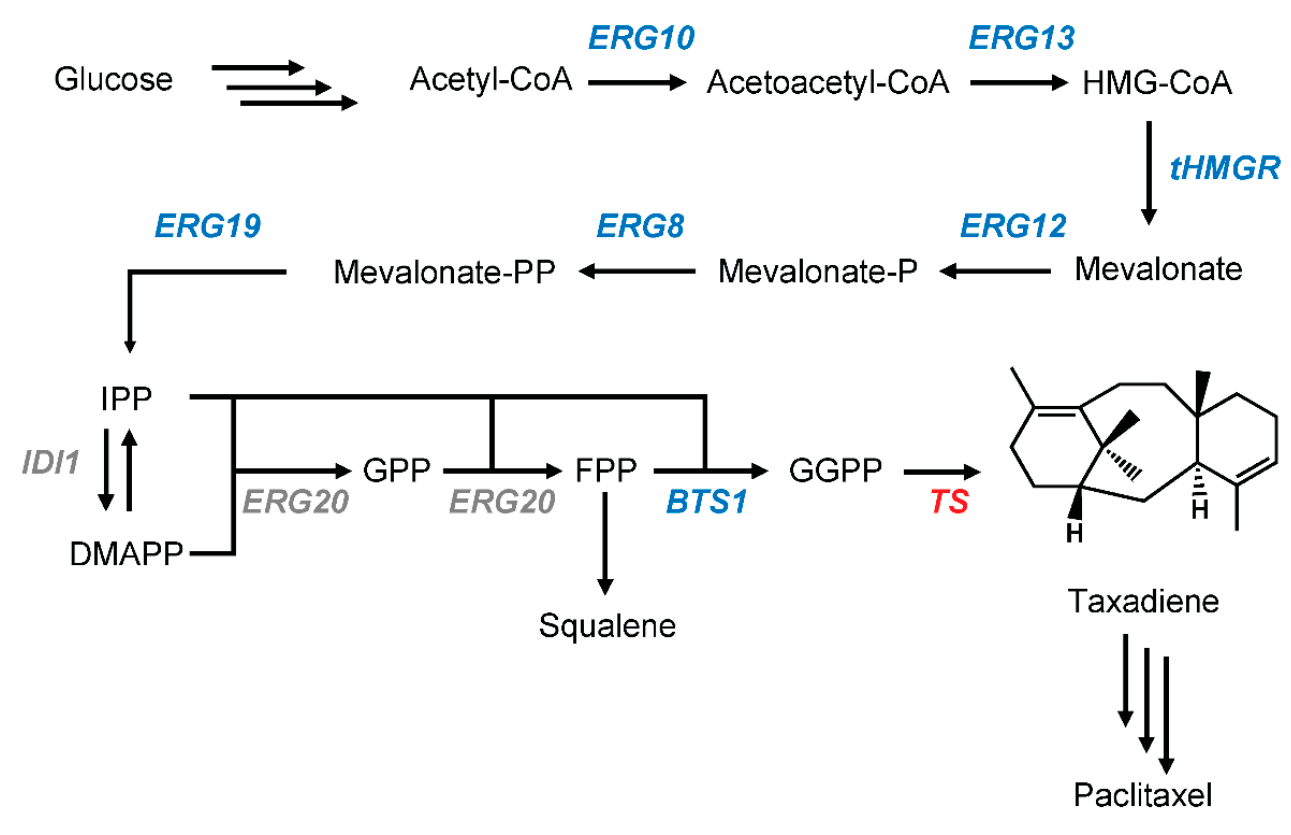
Figure 1. A schematic diagram of the taxadiene-producing yeast construction in S . cerevisiae . The overexpressed genes are shown in blue. The heterologous taxadiene synthase is shown in red. The endogenous genes without any modification are shown in grey.